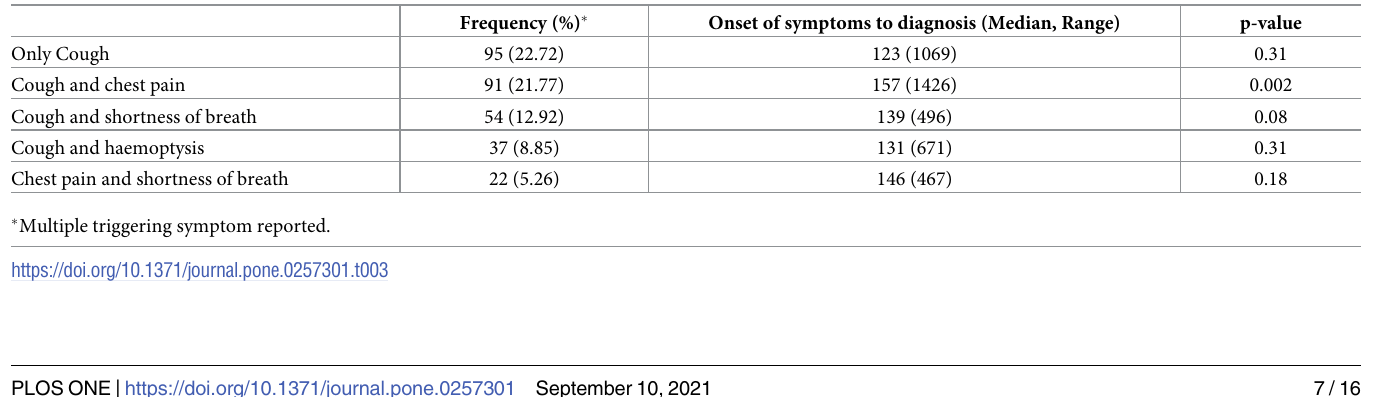
Table 3. Association with triggering symptoms and duration of intervals (N =